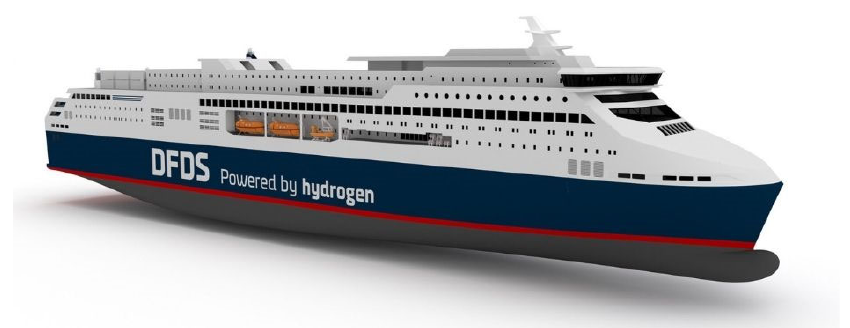
Figure 14. The Viking Energy [113]. (Source: TradeWindsnews).